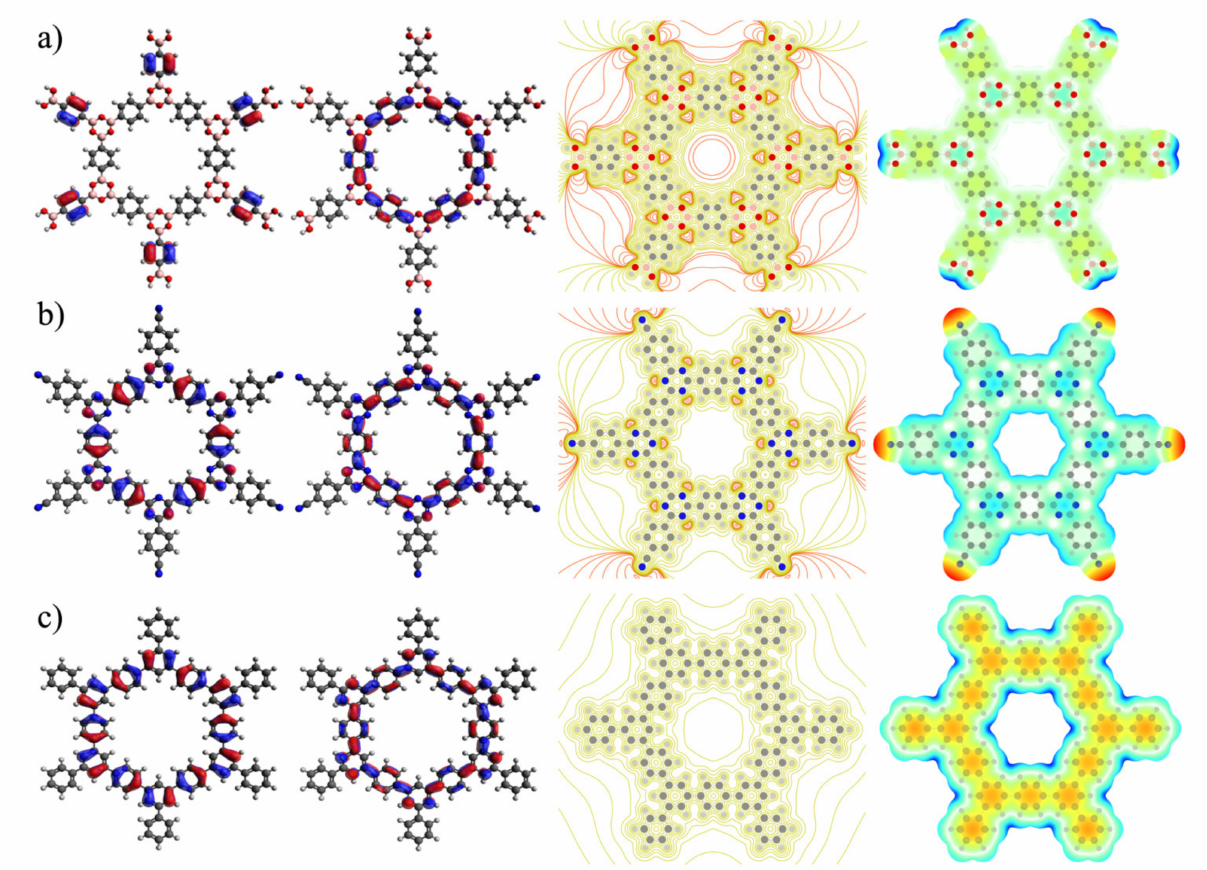
Figure 6. HOMO, LUMO, ESP contour and map, respectively, from left to right for ( a ) COF-1, ( b ) CTF-1 and ( c ) TPG. This visualization supports the result of ASE for COF-1. In agreement with the ASE calculation, the ESP contour showed that electron currents inside the pore led to aromatic stabilization if COF-1 is built by those fragments (Figure 4d). Although the ESP contour of CTF-1 illustrated only a small, concentrated electron density on nitrogen atoms in triazine rings, these negative potentials did not contribute to the resulting electron density within the pore. No negative potential was detected by ESP contour for TPG since there are no lone pair electrons or any other highly concentrated electron in the structure. However, ESP map revealed that TPG sheet has provided localized electron cloud in center of phenyl ring which is not shared with neighbor rings. ESP map for COF-1 and CTF-1 has alternatively pictured a more natural electron density surface caused by higher electron